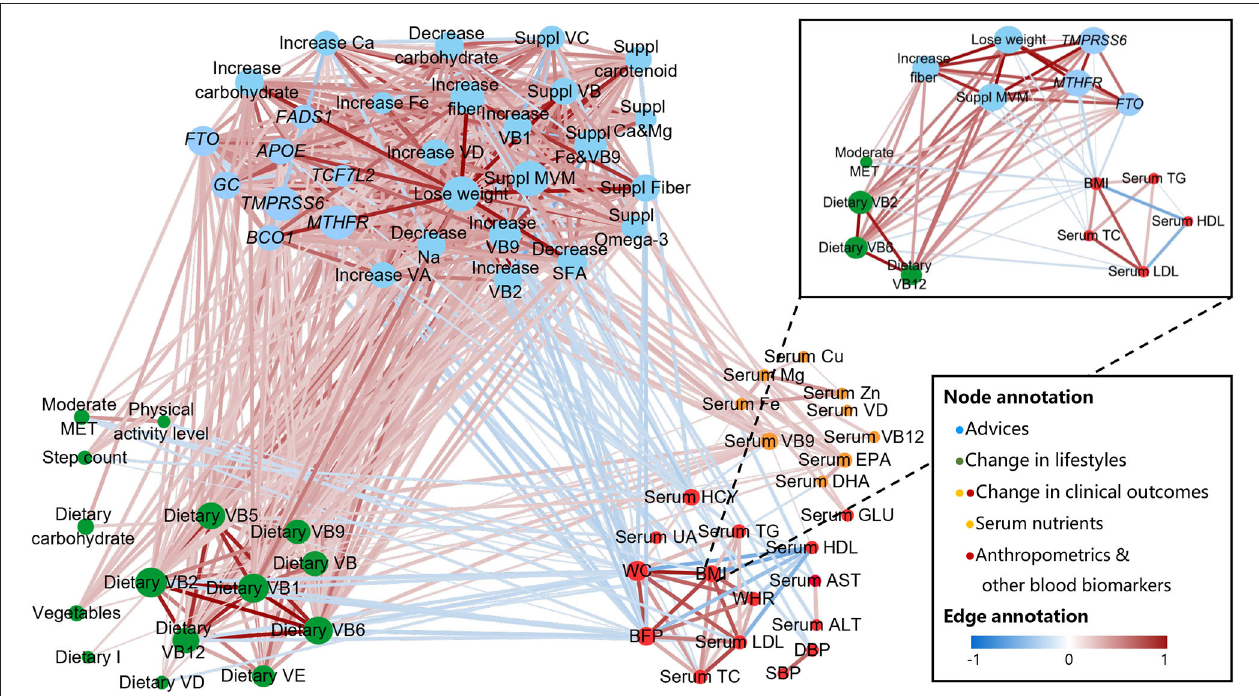
FIGURE 5 | Longitudinal correlation network of advice, genotype, lifestyles, and clinical outcomes. Connections were calculated by Spearman or Point-Biserial with Benjamini-Hochberg-corrected P < 0.05 and then plotted as a network by Cytoscape. Nodes are colored according to (1) group of advice, including genetic risk notification (e.g., FTO ), lifestyle guidance (e.g., lose weight), and nutritional supplements (e.g., Suppl MVM), (2) change in lifestyles (diet and PA), and (3) change in clinical outcomes (anthropometric measurements and blood biomarkers). Node sizes are proportional to betweenness centrality. Edge weights are proportional to the correlation strength, and colors correspond to the direction of association (positive: red; negative: blue). Sub-network in top right shows an example of how “BMI” change be associated with the advice, genotype, lifestyles, and clinical outcomes. ALT, alanine aminotransferase; AST, aspartate aminotransferase; BFP, body fat percentage; BMI, body mass index; Ca, calcium; Cu, copper; DBP, diastolic blood pressure; DHA, docosahexaenoic acid; EPA, eicosapentaenoic acid; Fe, iron; GLU, glucose; HCY, homocysteine; HDL, high density lipoprotein; I, iodine; LDL, low density lipoprotein; MET, metabolic equivalent of task; Mg, magnesium; MVM, multiple vitamin mineral; Na, sodium; SBP, systolic blood pressure; SFA, saturated fatty acid; TC, total cholesterol; TG, triglycerides; UA, uric acid; VA, vitamin A; VB, vitamin B; VC, vitamin C; VD, vitamin D; VE, vitamin E; WC, waist circumference; WHR, waist-to-hip ratio; Zn,